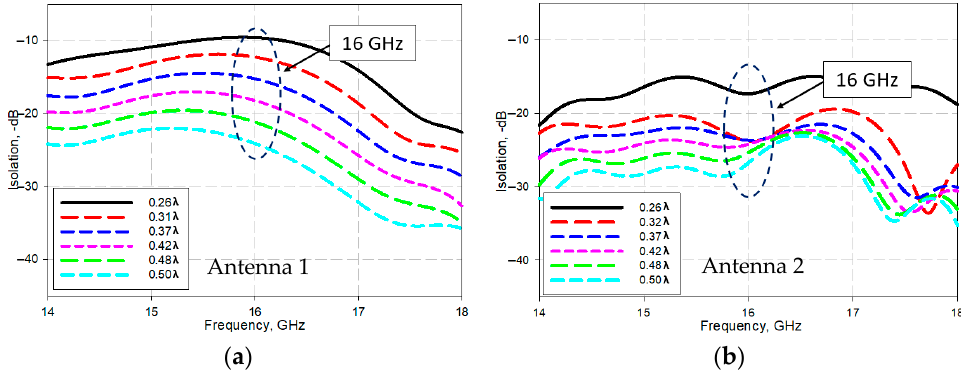
Figure 5. Isolation for various spacing distances, d , ( a ) without (Antenna 1) and ( b ) with parasitic elements (Antenna 2).